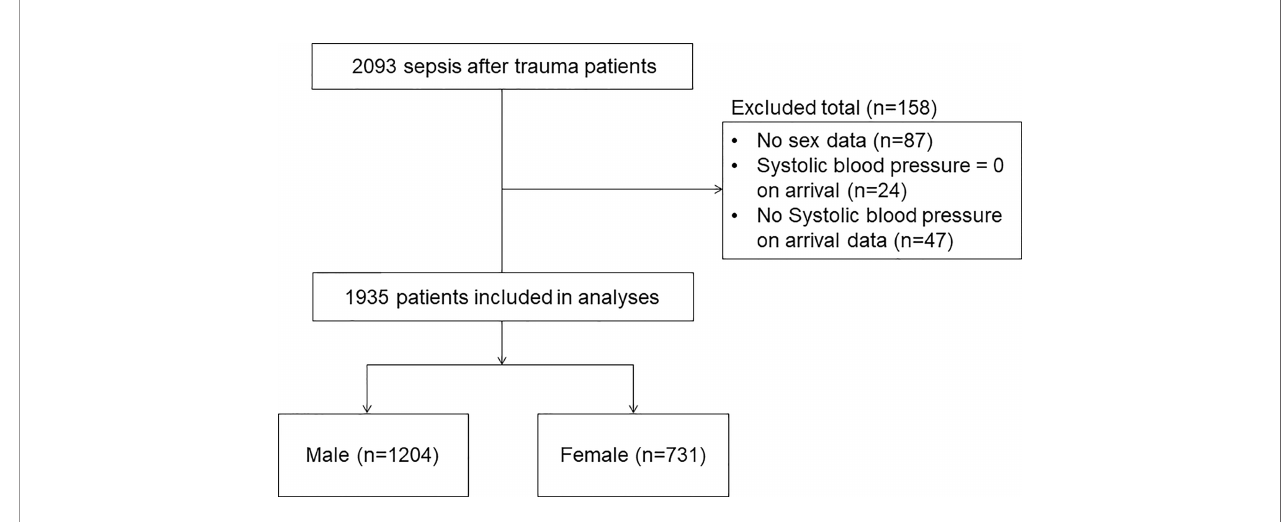
FIGURE 1 | Flow diagram showing the process for selecting patients.